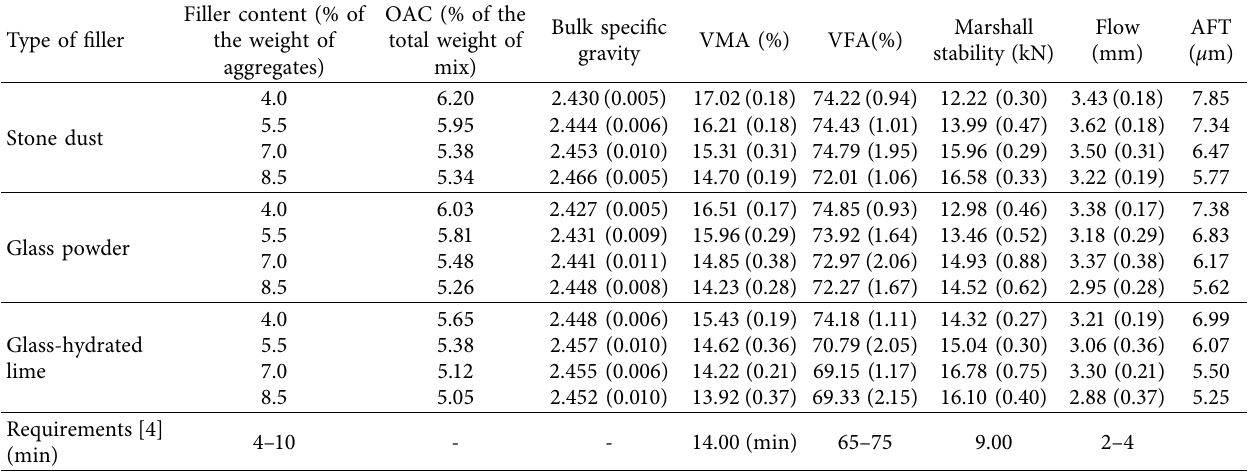
Table 5: Various properties of asphalt mixes at different filler contents (standard deviations are mentioned in the parenthesis). Type of